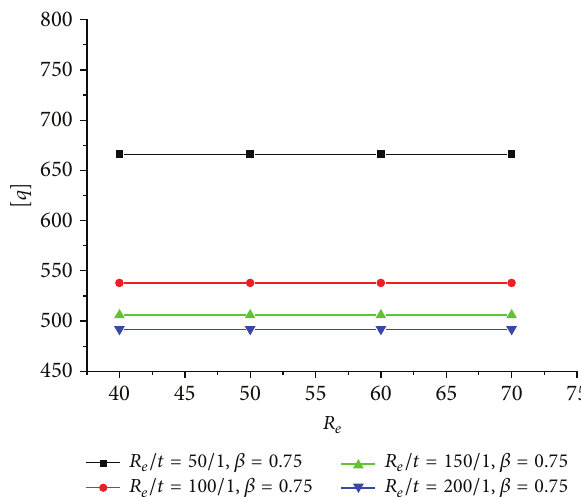
Figure 10: [𝑞] - 𝑅 𝑒 relation of the CFRP sheet confined GFRP pipe when 𝛽 are constants and 𝑡 is 1.336